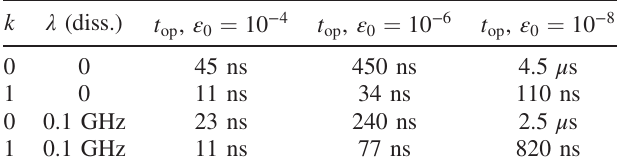
TABLE II. Braiding time using nearly adiabatic unitary evo- lution for the system discussed in Sec. VI with Δ ¼ 10 GHz and temperature T ¼ 0 . 001 Δ . The first two columns label the smoothness of the time evolution of the system Hamiltonian ( k ¼ 0 , 1) and whether the system-bath coupling is λ ¼ 0 (no dissipation) or λ ¼ 0 . 01 Δ (dissipation). The third, fourth, and fifth columns list the braiding time to reach a target error probability of ε 0 ¼ 10 − 4 , 10 − 6 , and 10 − 8 , respectively, between two turning points. A smaller target error probability increases the corresponding braiding